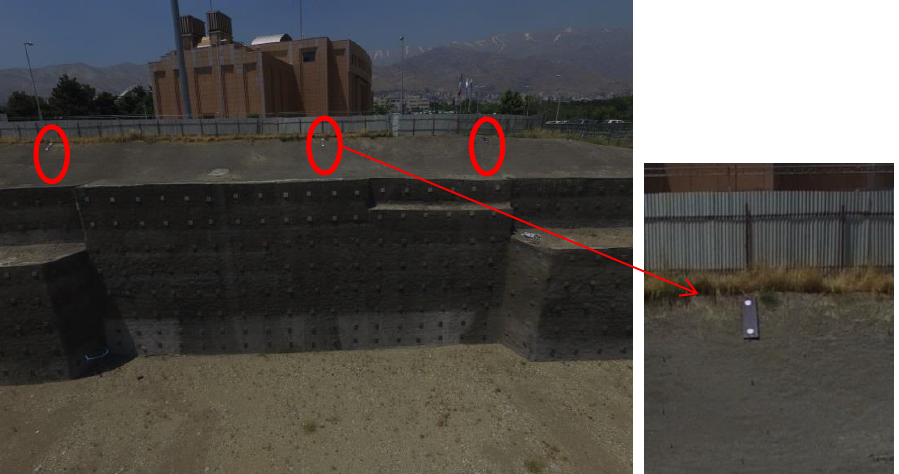
Figure 17. Examples of the scale bars used across the project area.